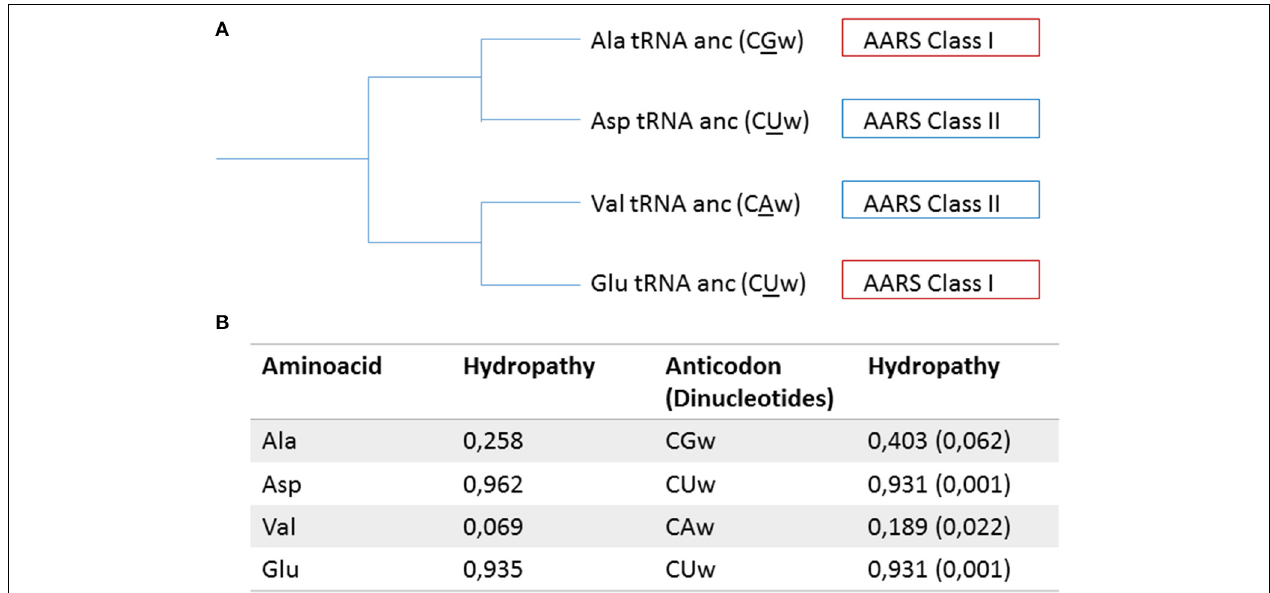
FIGURE 1 | Model for the selection mechanism between tRNAs and aminoacyl-tRNA synthetases. In (A) A branch of the tRNA phylogeny (derived from Farias et al., 2014), where the anticodons are in parentheses, w corresponds to the wobble position and the second base of the anticodons are underlined; the corresponding class of each aminoacyl-tRNA synthetase is indicated in the boxes. (B) The hydropathy